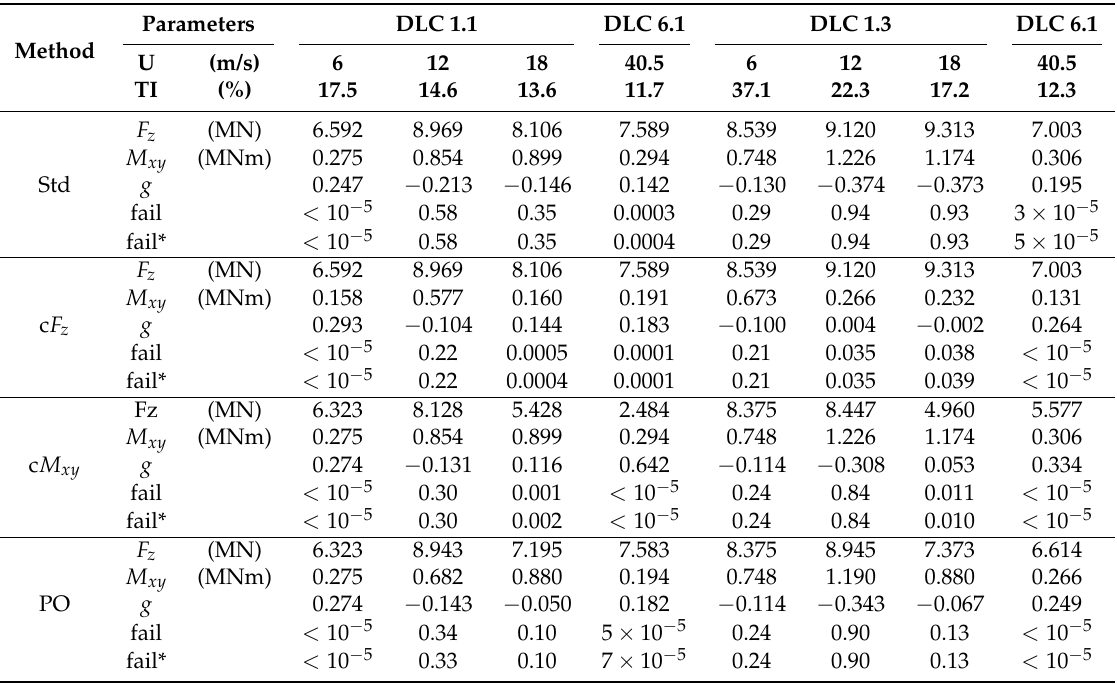
Table 3. Results for the OC4 jacket, for the Y-joint at the bottom of the structure. Both power production under standard conditions (DLC 1.1) and extreme turbulence (DLC 1.3), as well as idling under extreme wind speeds (DLC 6.1) were assessed. The latter was investigated for two different values of the turbulence intensity (TI). Std: standard approach using univariate maxima; c F z , c M xy : contemporaneous maxima for F z or M xy , respectively; PO: worst Pareto-optimal load vector; g: value of the limit state equation (Equation (5)); fail: failure probability, estimated by sampling random values from yield strength; fail*: additional sampling for manufacturing uncertainty. In contrast to Figure 1, these results are based on the full time series